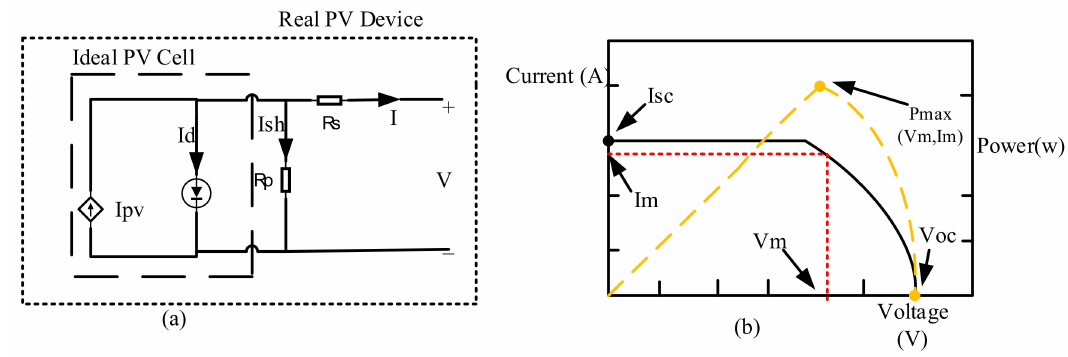
Figure 1. PV cells power circuit and curve: ( a ) PV cell model; ( b ) V-I characteristics with